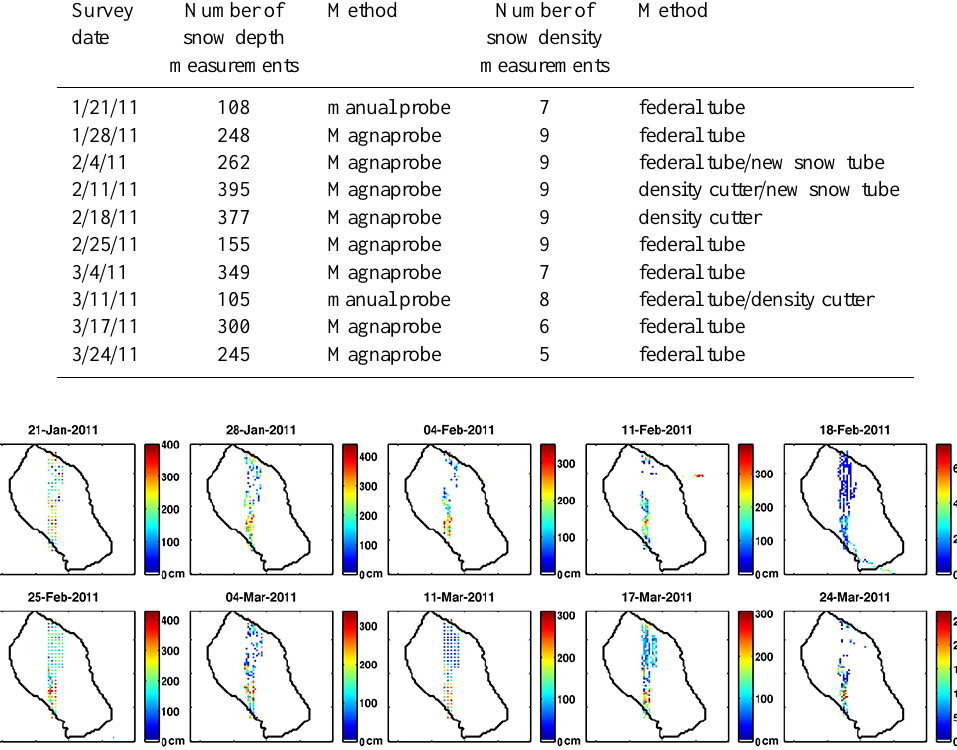
Figure 6. Gridded mean snow depth from 10 snow